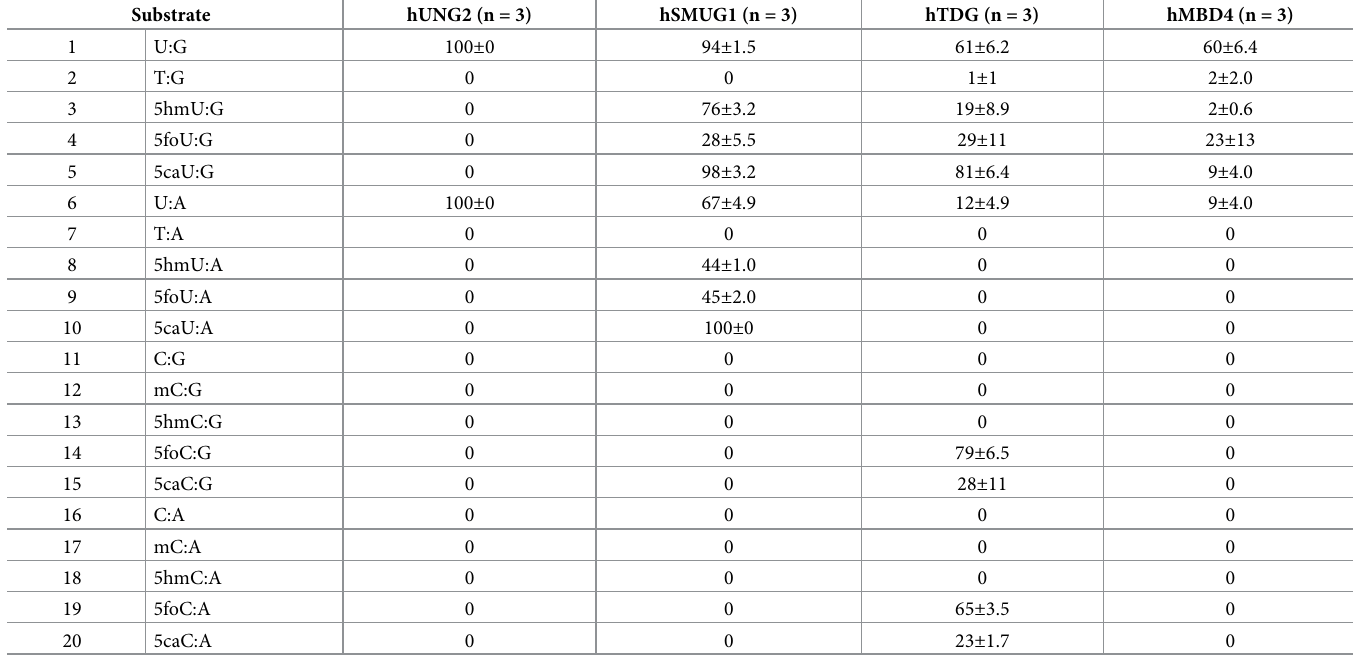
Table 1. Extent of cleavage for indicated bases in duplex oligonucleotides by members of the human uracil glycosylase family. Excision studies for analogs paired with G used a hyTDG-lyase (Y163K) to cleave the phosphodiester backbone whereas those paired with A were cleaved with NaOH. Values shown in the table represent the averages and standard deviations from three independent experiments. Cleavage of 5foU-containing oligonucleotides were adjusted for thermal hydrolysis by subtraction of cleavage observed in no enzyme controls. Cleavage of 5foC:A base pairs was adjusted for alkaline hydrolysis by subtraction of cleavage in no enzyme controls. Glycosy- lase excision of 5caC paired with A by hTDG was also measured using hyTDG-lyase (Y163K) and a value of 50.3 ± 3.9% cleavage was observed. Phosphodiester backbone cleavage using the hyTDG-lyase (Y163K) underestimates glycosylase cleavage when the target pyrimidine is paired with A rather than G.